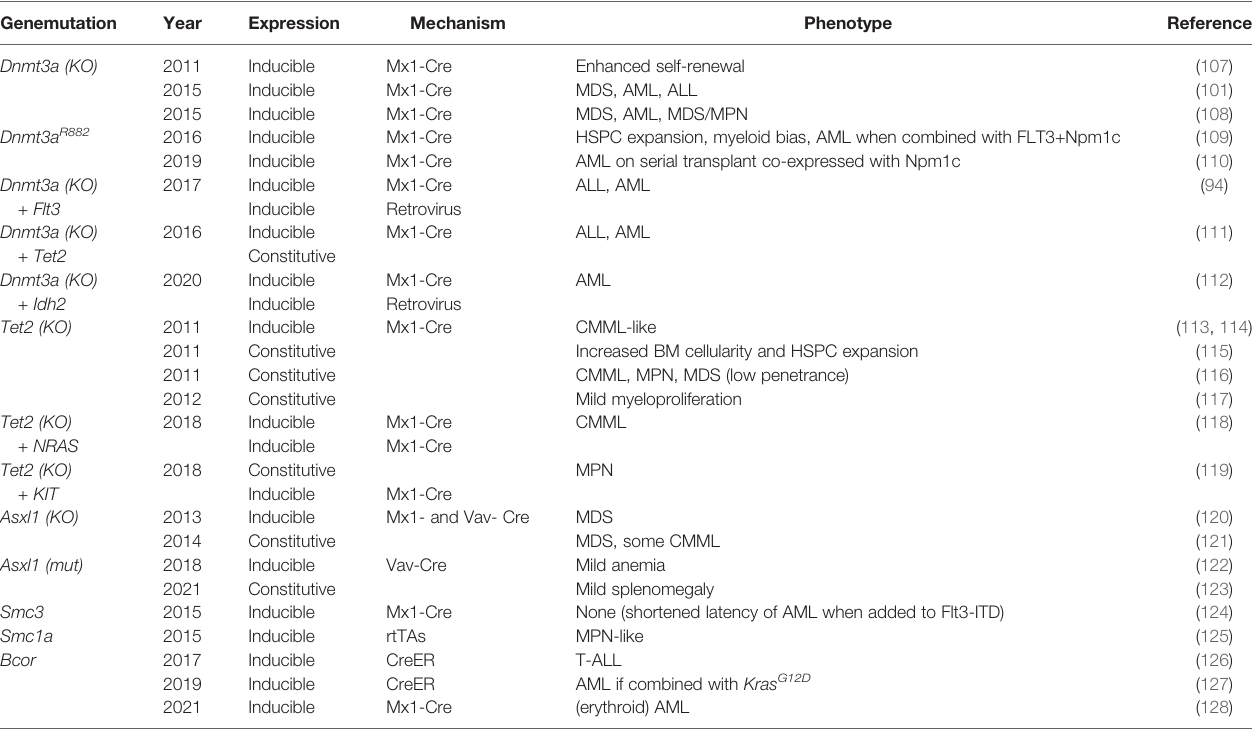
TABLE 3 | Mouse models of epigenetic